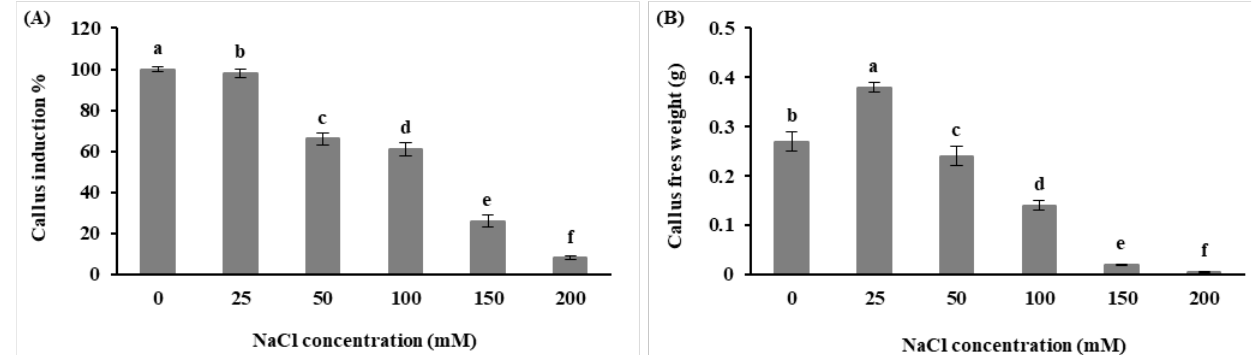
Figure 2. Effect of salinity on callus induction and callus fresh weight of Carum copticum. Stem explants were cultured on MS medium containing 1 mg L − 1 BAP, 0.25 mg L − 1 2,4-D, and 0, 25, 50, 100, 150, and 200 mM NaCl. Callus induction ( A ) and callus fresh weight ( B ) were measured after 4 weeks of salt treatment. Values represent the mean of three replicates with error bars indicating ± standard errors, and dissimilar letters are significantly different according to Duncan’s test ( p ≤ 0.05).